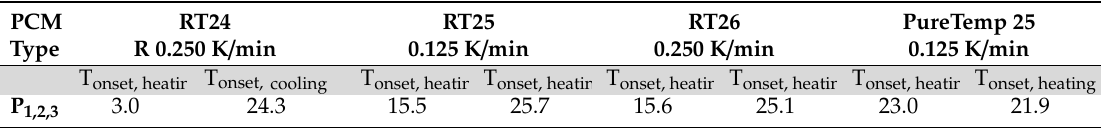
Table 3. Comparison of extrapolated peak initial temperatures (assigned to the